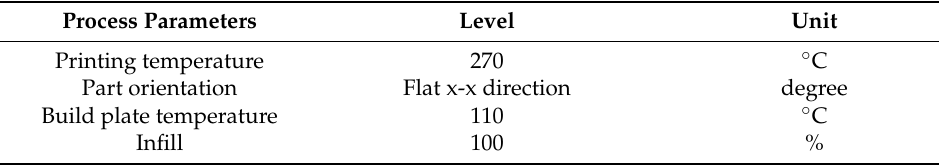
Table 2. Fixed parameters and their levels.